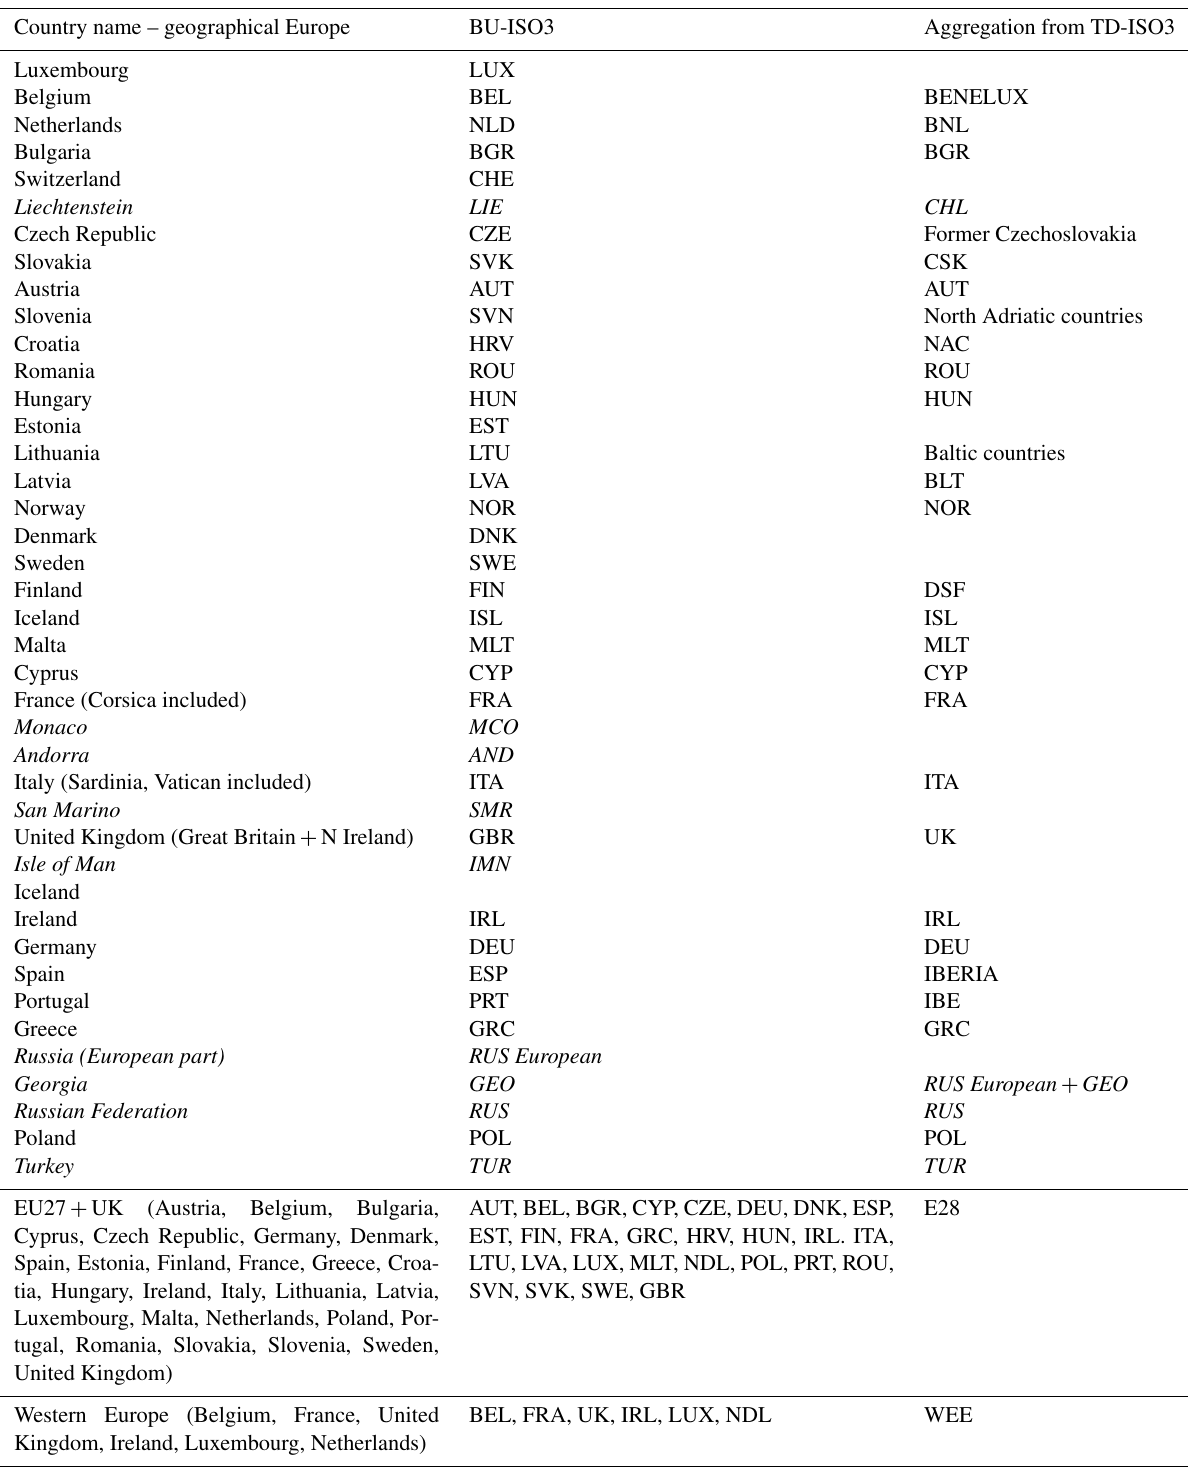
Table A1. Country grouping used for reconciliation purposes between BU and TD estimates. The countries and groups of countries in italic are not directly used by this study, but their figures and data are available on the VERIFY project web portal at http://webportals.ipsl.jussieu. fr/VERIFY/FactSheets/ (last access: January